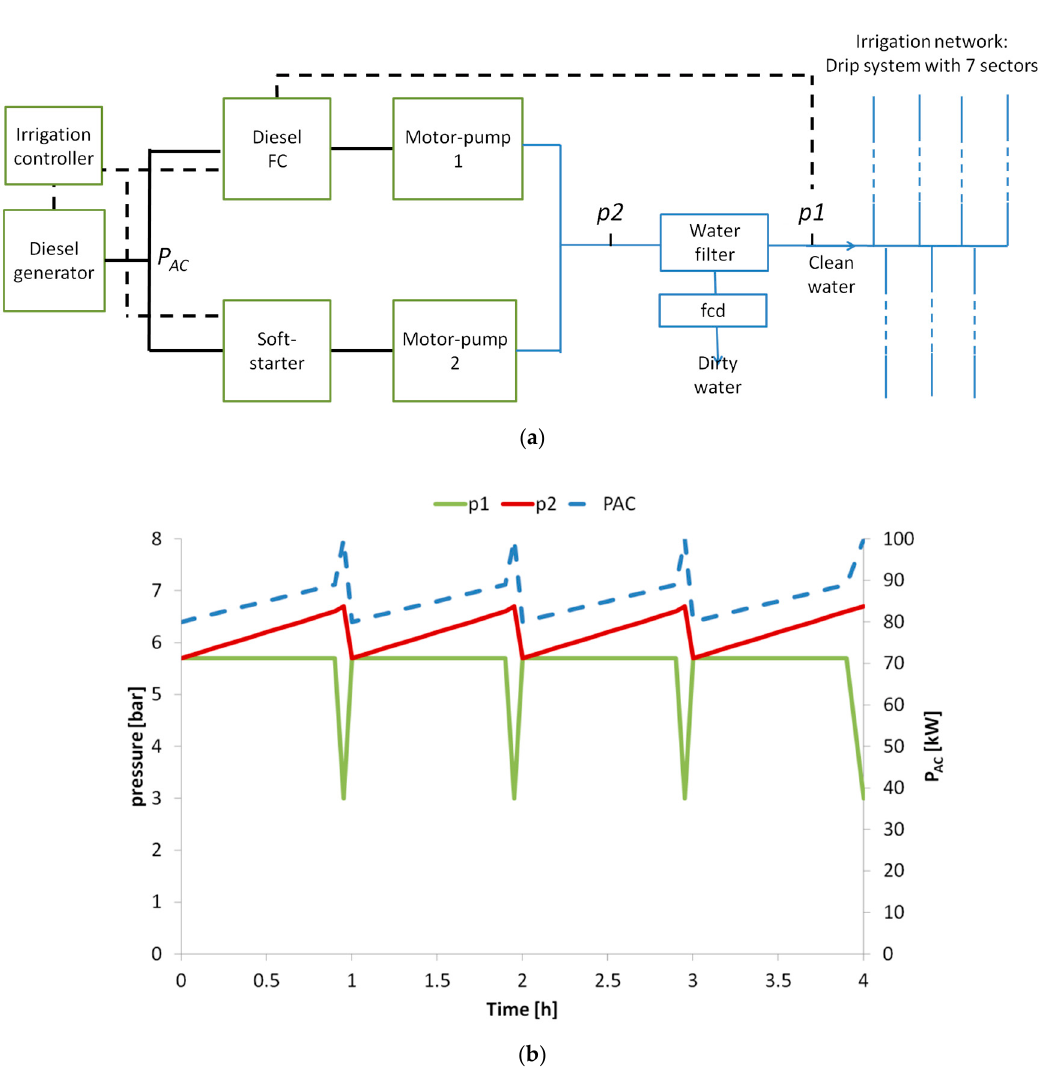
Figure 1. ( a ) Pre-existing irrigation system configuration: The electric power at the output of the diesel generator, P AC , is controlled to keep the hydraulic pressure constant at the input of the irrigation network, p 1 . Black and blue lines represent the electricity and water, respectively. ( b ) Cycling evolution of the AC power ( P AC ) and pressure ( p 1 and p 2 ) due to water filtering and filter cleaning periods.